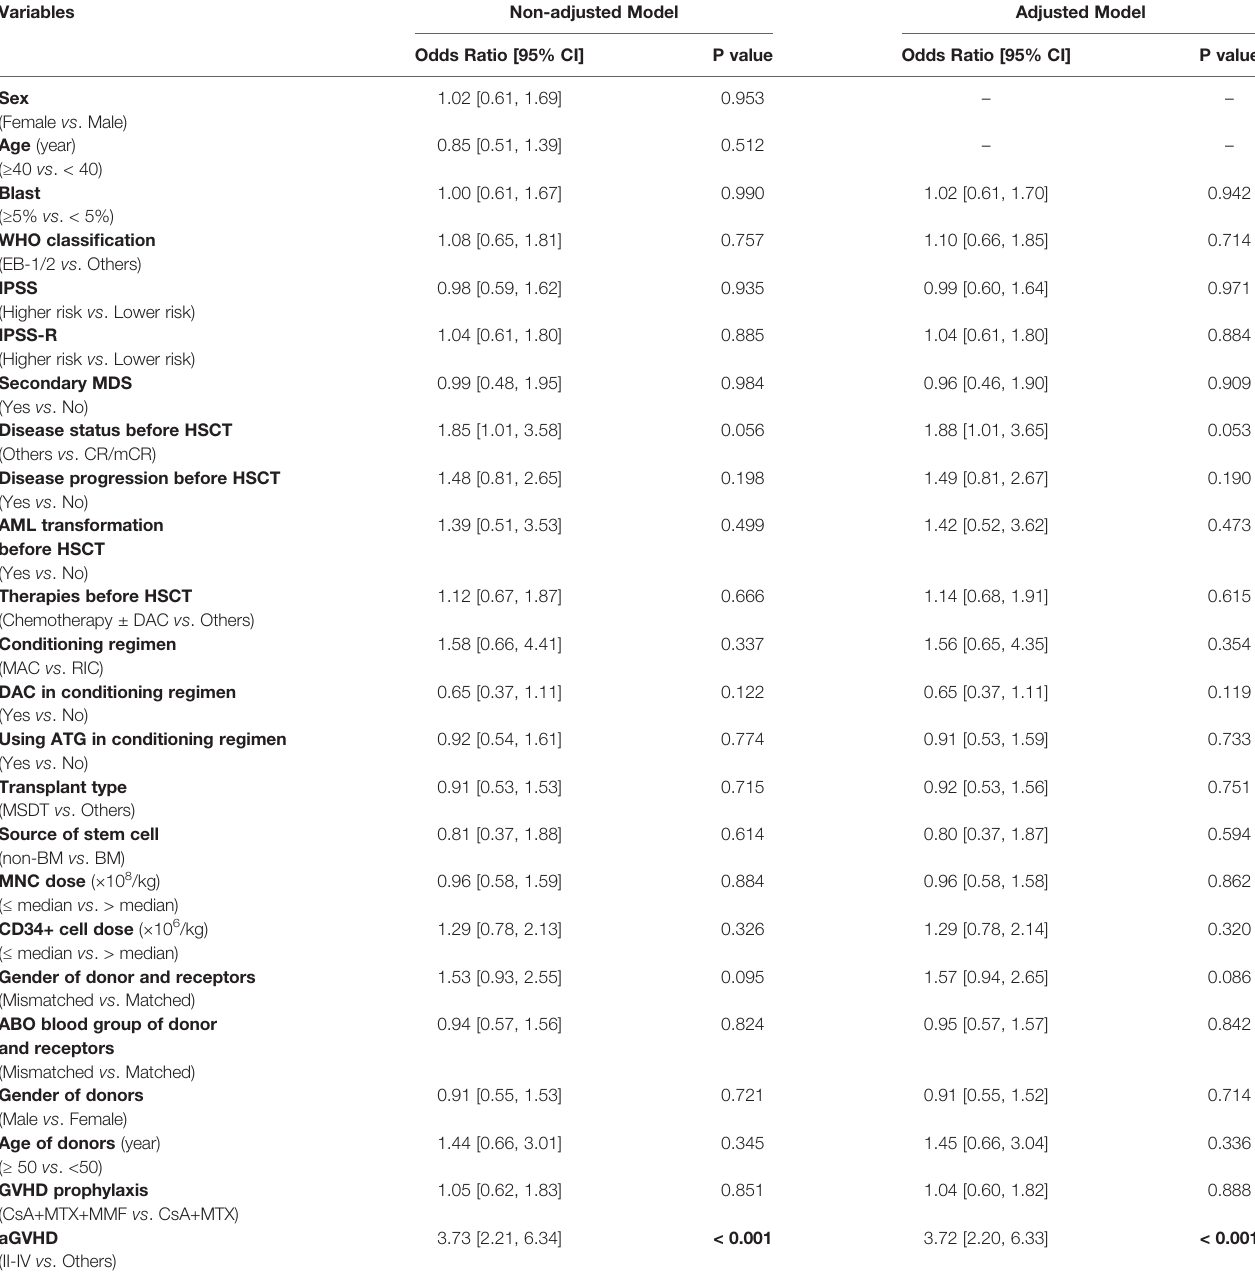
TABLE 3 | Univariate analysis of risk factors associated with thrombocytopenia in MDS after HSCT. Variables Non-adjusted Model Adjusted